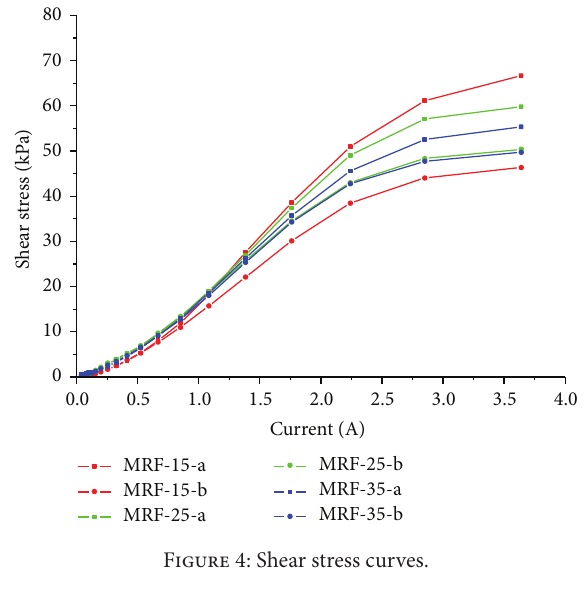
Figure 4: Shear stress curves.